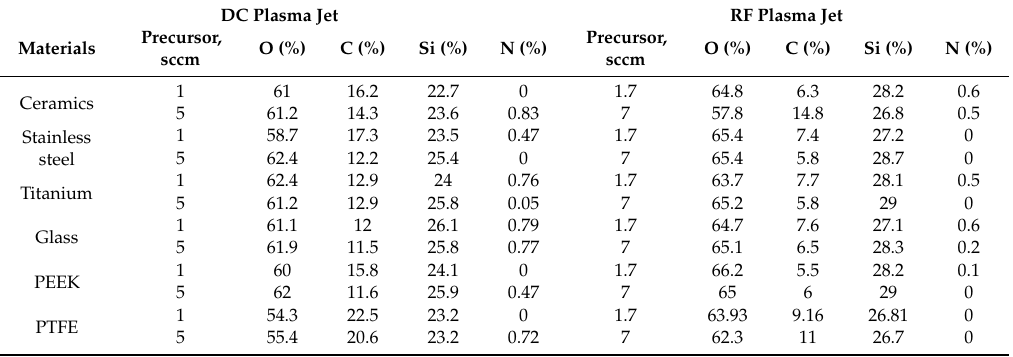
Table A2. Atomic concentration of elements in the films deposited by DC plasma jet (1) and RF plasma jet (2) for various air flow rates and several substrate